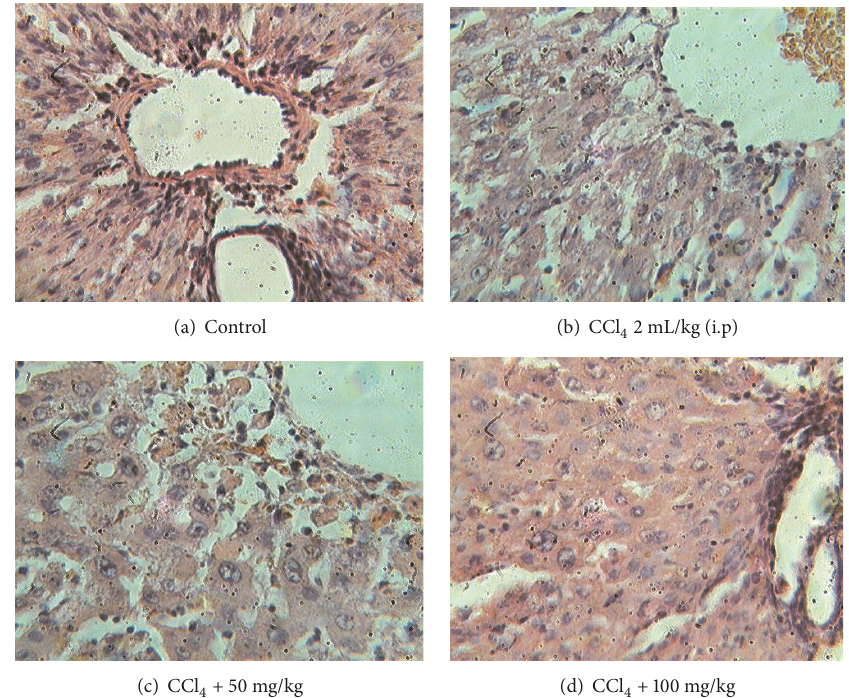
Figure 4: Microphotograph of rat liver. (a) Vehicle control group; (b) CCl 4 2 mL/kg (i.p) positive control group; (c) CCl 4 + 50 mg/kg of extract group; (d) CCl 4 + 1000 mg/kg of extract group (ip: